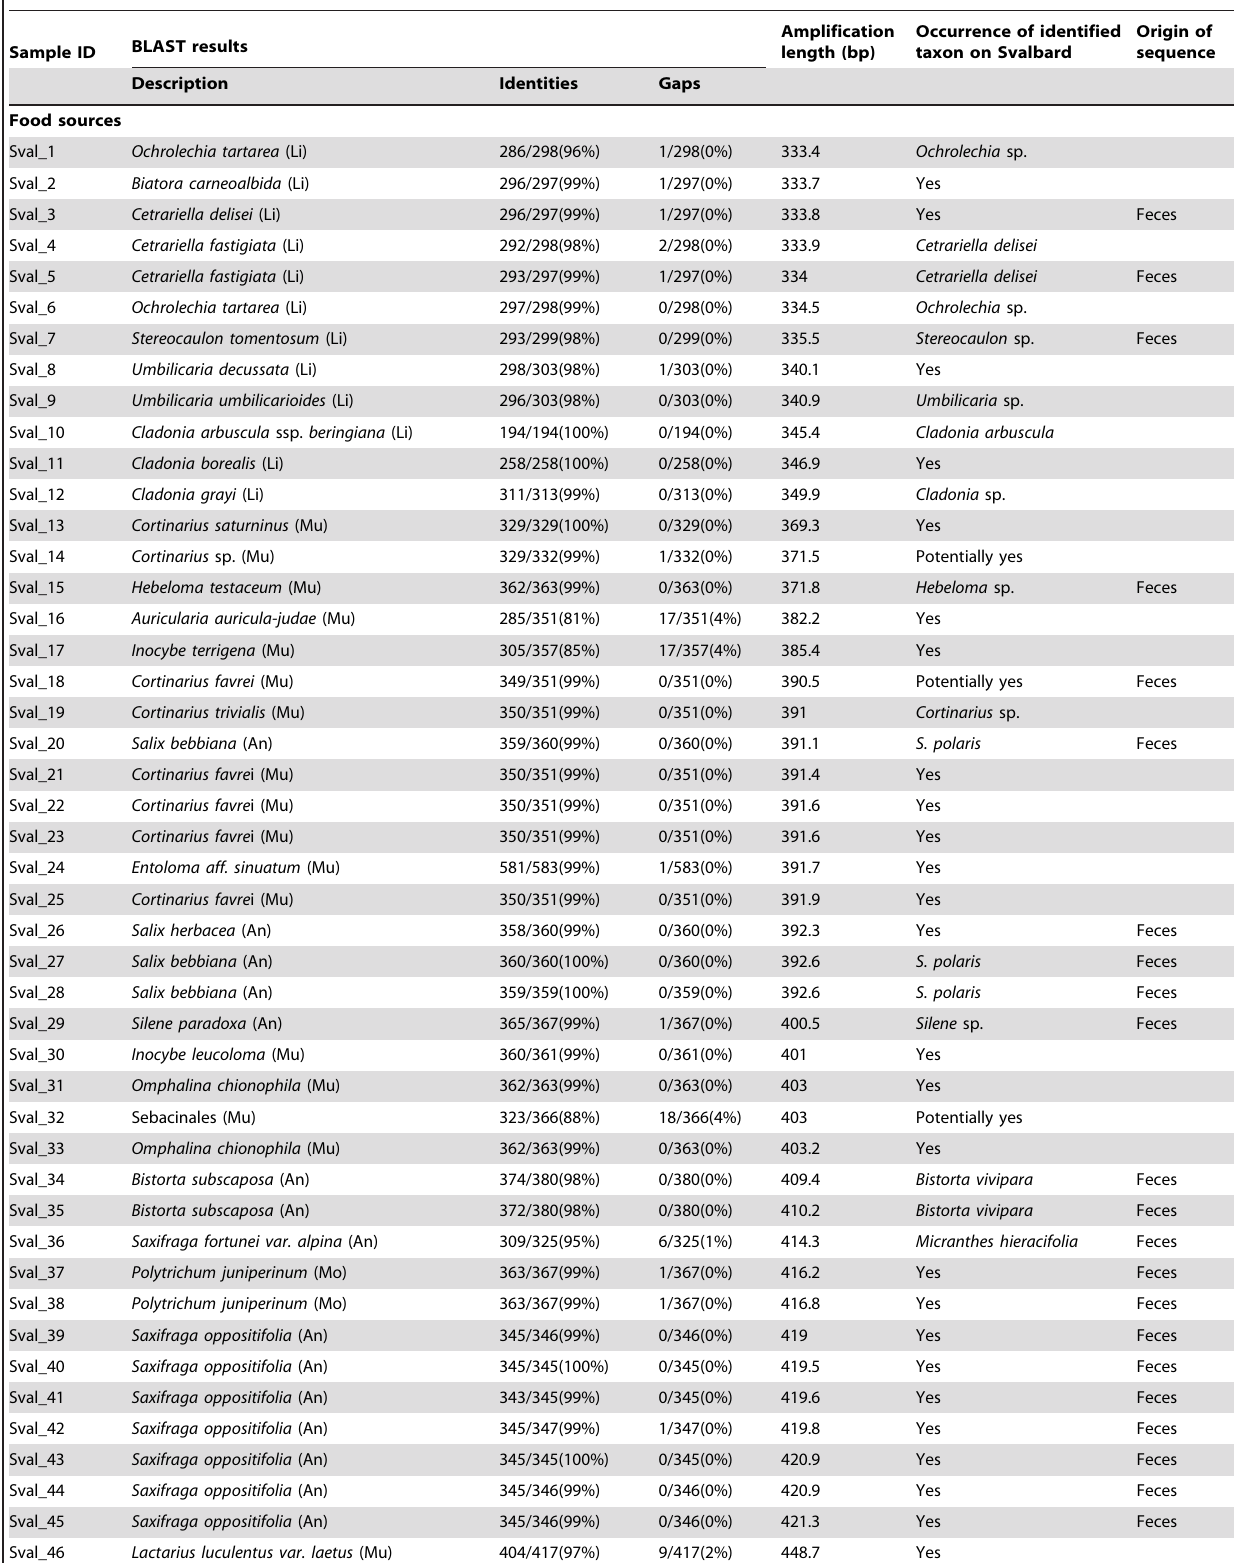
Table 2. Constructed LH database between 30 different sequences containing collected potential food sources of Svalbard reindeer ( R. tarandus platyrhynchus ) and 27 sequences detected from fecal samples by